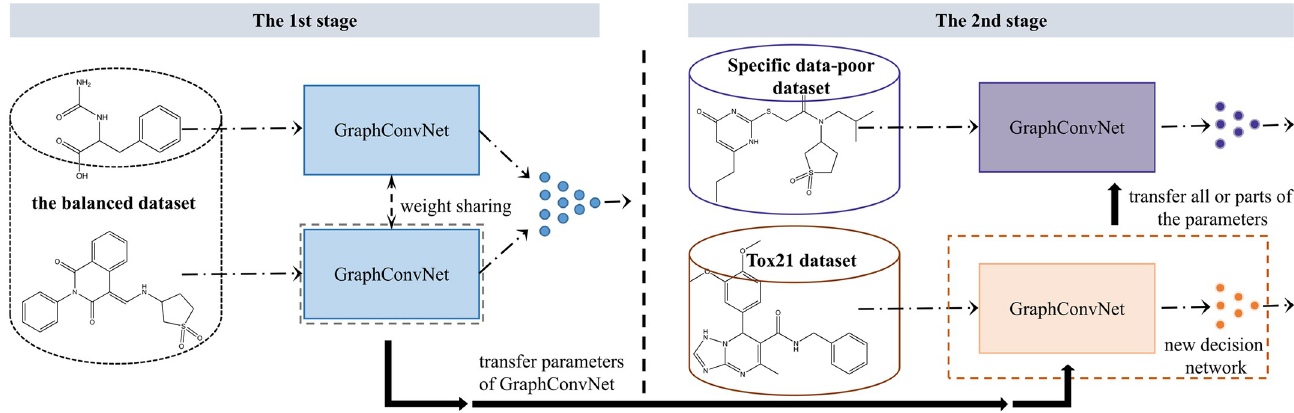
Fig 4. The transfer learning workflow for data-poor targets. Two stages are used to transfer model parameters from data-rich targets to data-poor targets in specific datasets.